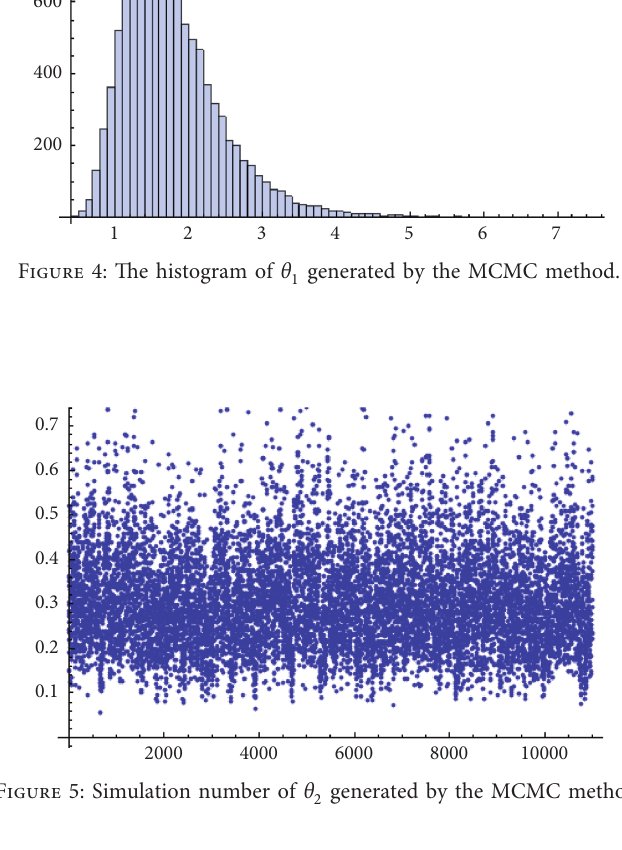
generated by the MCMC method. 2